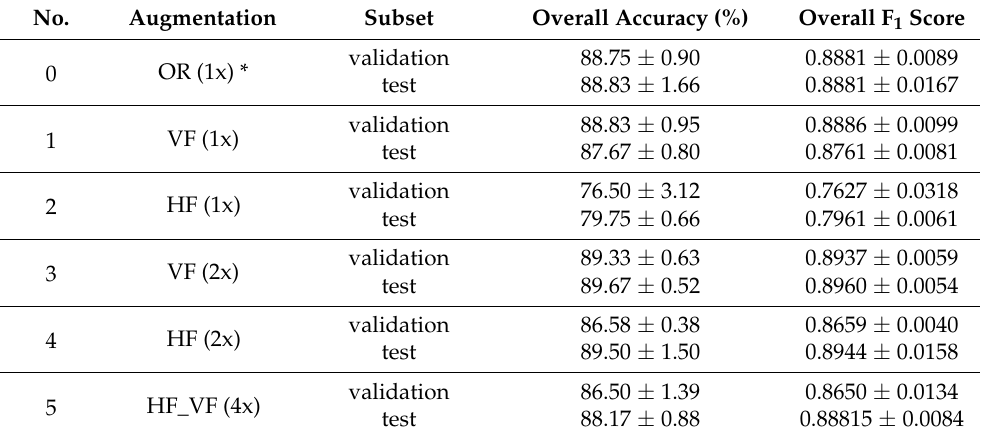
Table 12. Assessment metric comparison of the cross-validation results with image transformation and data